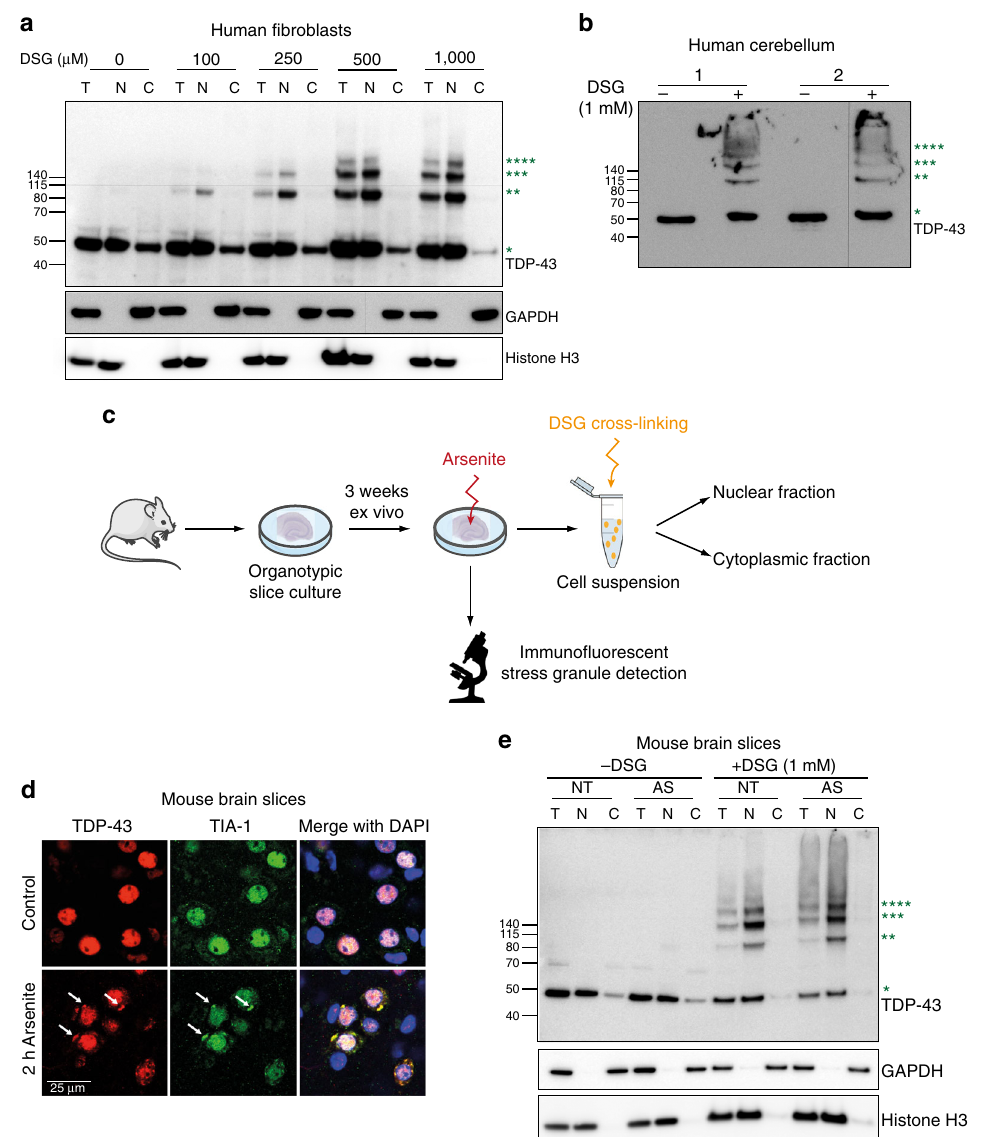
Fig. 1 TDP-43 oligomers are expressed in human cells and brain and resist oxidative stress. a Immunoblots (from 12% denaturing polyacrylamide gels) of human fi broblast fractions obtained upon incubation with increasing concentration of DSG cross-linker followed by nucleo-cytoplasmic fractionation. In the upper panel , high molecular weight bands (marked with green asterisks ) are detected with anti-human TDP-43 antibody at increasing concentrations of DSG in the nuclear fraction (N) and in total cell lysates (T), but not in the cytoplasmic fraction (C). Lower panels show immunoblots for cytoplasmic marker GAPDH, or nuclear marker histone H3. Immunoblots are representative of three independent experiments. b Immunoblots (from 12% denaturing polyacrylamide gels) of human cerebellum samples. High molecular weight TDP-43 bands are detected in 1 mM DSG cross-linked samples ( green asterisks ) compared to samples obtained in the absence of cross-linker. Immunoblots are representative of three independent experiments. Full immunoblots with molecular weight marker are shown in Supplementary Fig. 1. c Schematic diagram depicting the experimental set-up for oxidative stress treatment in mouse organotypic slice cultures followed by DSG mediated cross-linking. Subset of images (such as eppendorf tubes and microscope) in the schematic fi gure were adapted from the Servier medical art (http://www.servier.com/slidekit). d Confocal microscopy images of non-treated (control) and arsenite- treated (2 h Arsenite) mouse brain slices, immunostained with antibodies against TDP-43 and TIA-1. Cytoplasmic TDP-43 granules ( red ) co-localize with the stress-granule marker TIA-1 ( green ). Merged images including DAPI-staining of nuclei ( blue ) are shown in the right panels . e Immunoblots (from 12% denaturing polyacrylamide gels) of control (NT) and arsenite-treated (As) mouse brain slices after cross-linking by DSG and nucleo-cytoplasmic fractionation. DSG-cross-linked oligomeric TDP-43 (marked with green asterisks ) remains localized in the nuclear fraction after oxidative stress. Immunoblots are representative of three independent